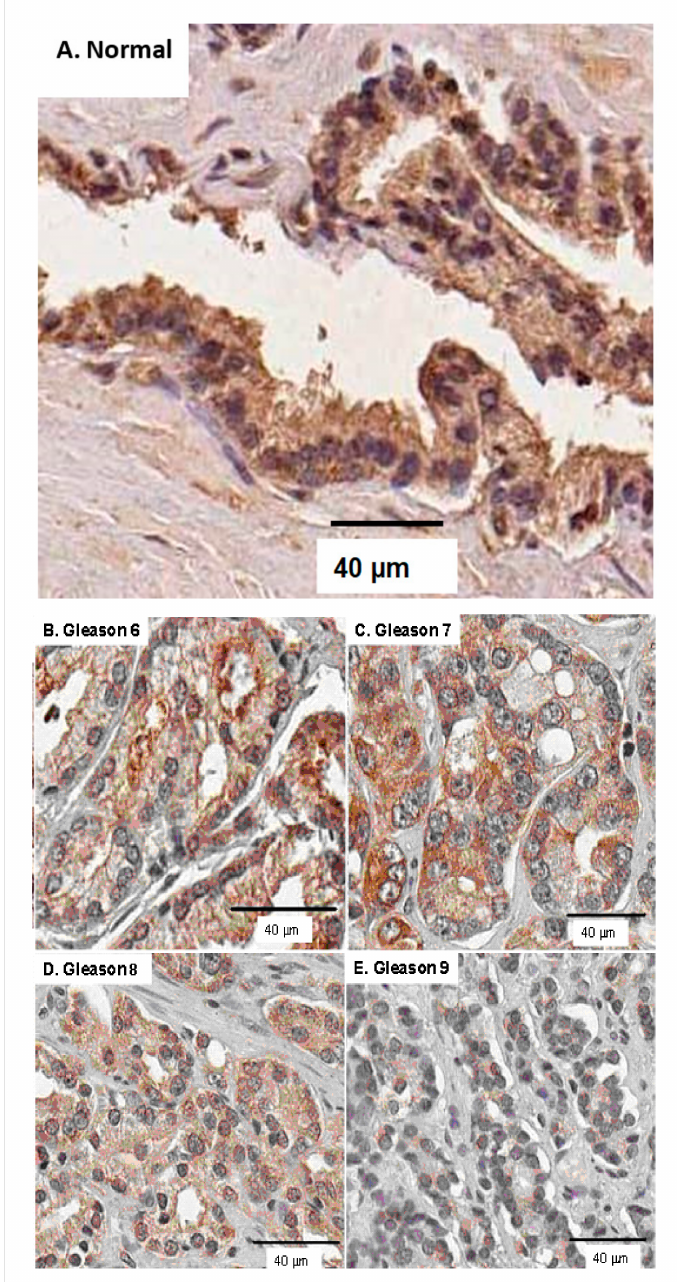
Figure 1. Representative images of normal and malignant prostate cancers, immunostained for